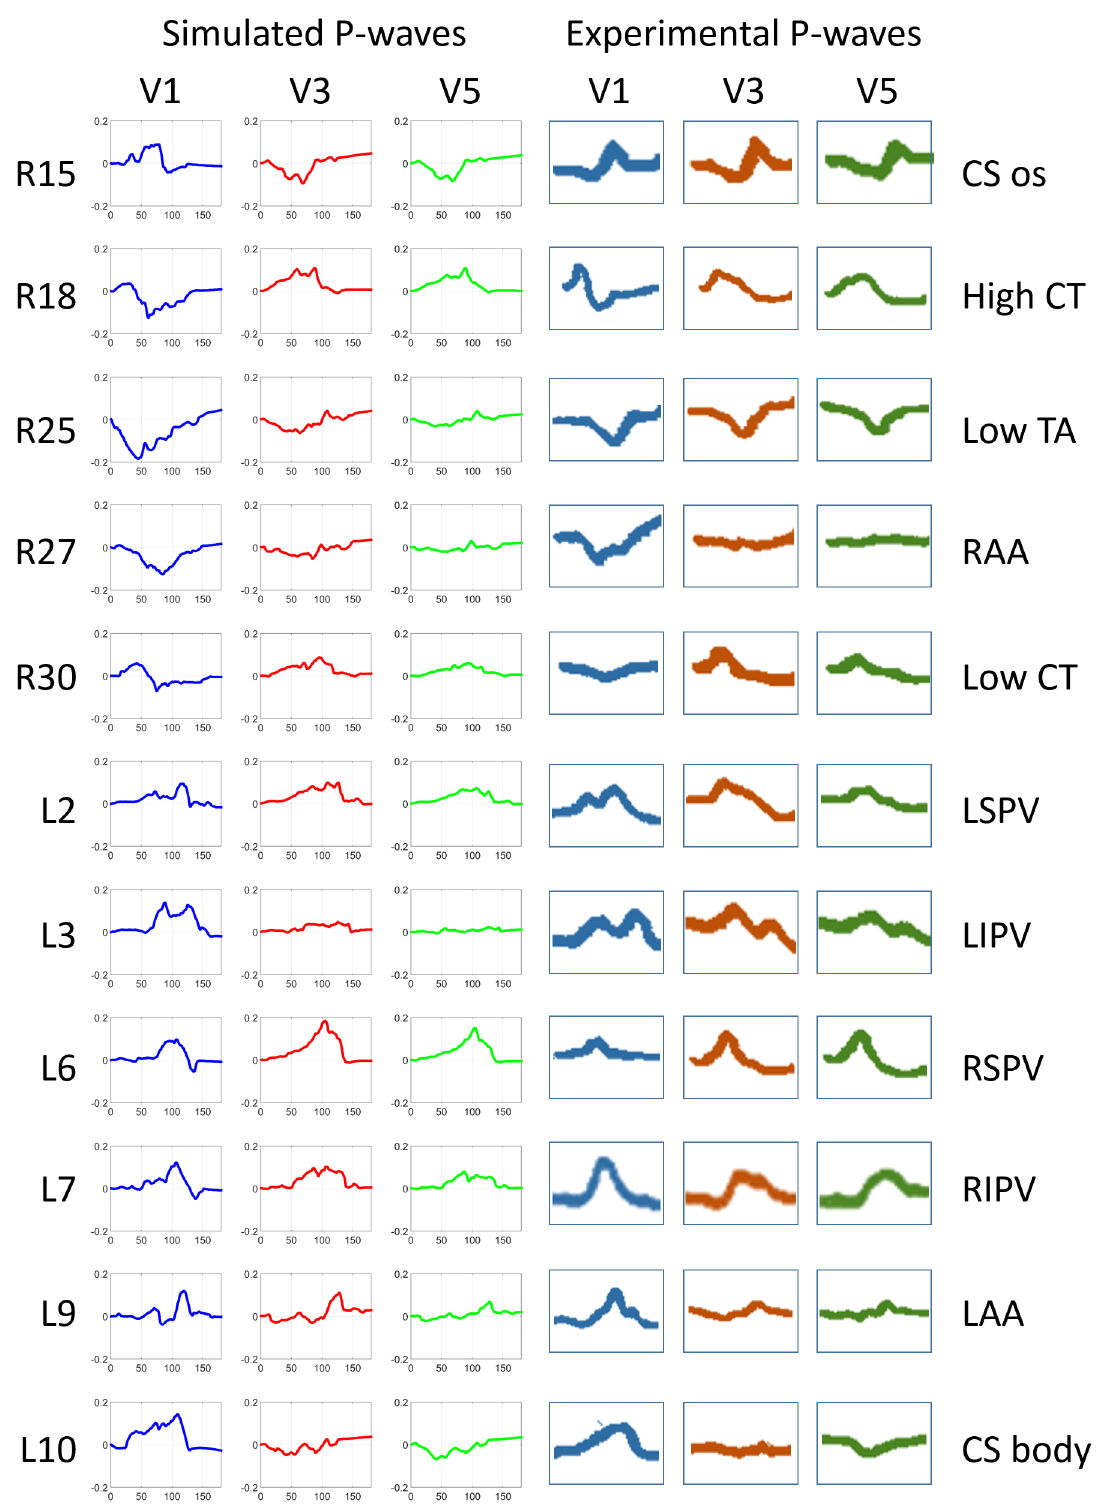
Fig 5. P-wave morphology registered in precordial leads produced by simulations (left panel) and by experimental activations (right panel). Left panel: P-wave registeredat V1 (blue), V3 (red) and V5 (green) from the RA simulations 15, 18, 25, 27 and 30 and from the LA simulations 2, 3, 6, 7, 9 and 10; Right panel: P-waves reproducedfrom the experimental